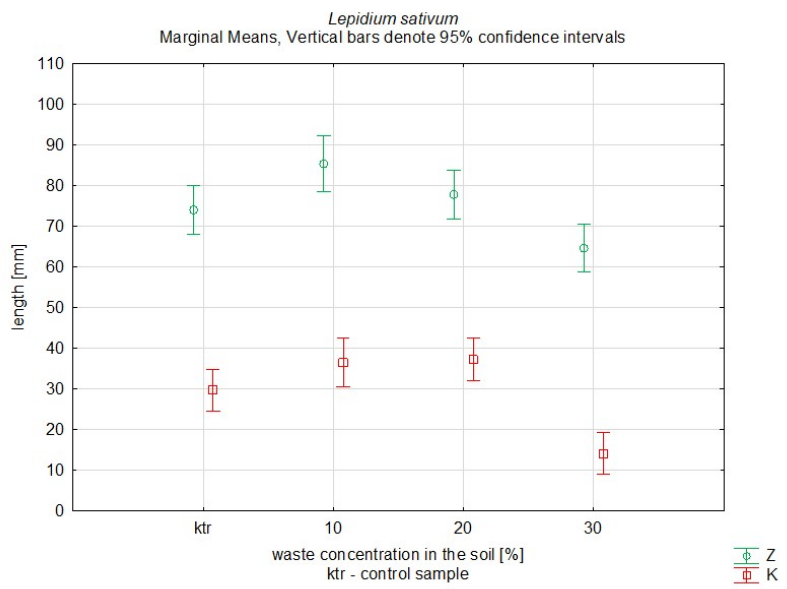
Figure 5. The growth of roots (K) and shoots (Z) of Lepidium sativum on the medium with various additions of waste.